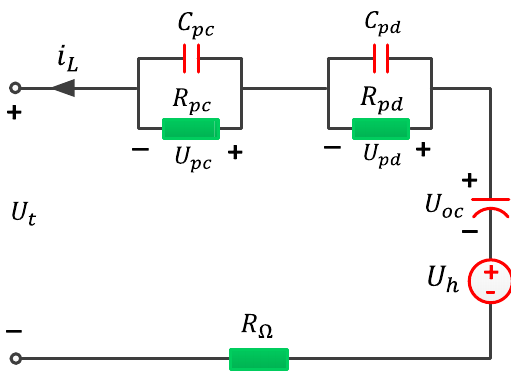
Figure 4. Expanded Federal Urban Driving Schedule (FUDS). 3. Battery Modeling 3.1. ECM As Figure 5 depicts, a second-order ECM is utilized in this work to capture battery electrical characteristics. The ECM comprises the voltage source ( (cid:1847) (cid:3042)(cid:3030) ), the hysteresis potential ( (cid:1847) (cid:3035) ), the internal resistor ( (cid:1844) (cid:3078) ), the activation polarization RC (resistor-capacitor) pair ( (cid:1844) (cid:3043)(cid:3030) //(cid:1829) (cid:3043)(cid:3030) ), and the concentration polarization RC pair ( (cid:1844) (cid:3043)(cid:3031) //(cid:1829) (cid:3043)(cid:3031) ) [19]. Then, the electrical relationships can be written as Equation (7) [11,13]: (cid:4688)